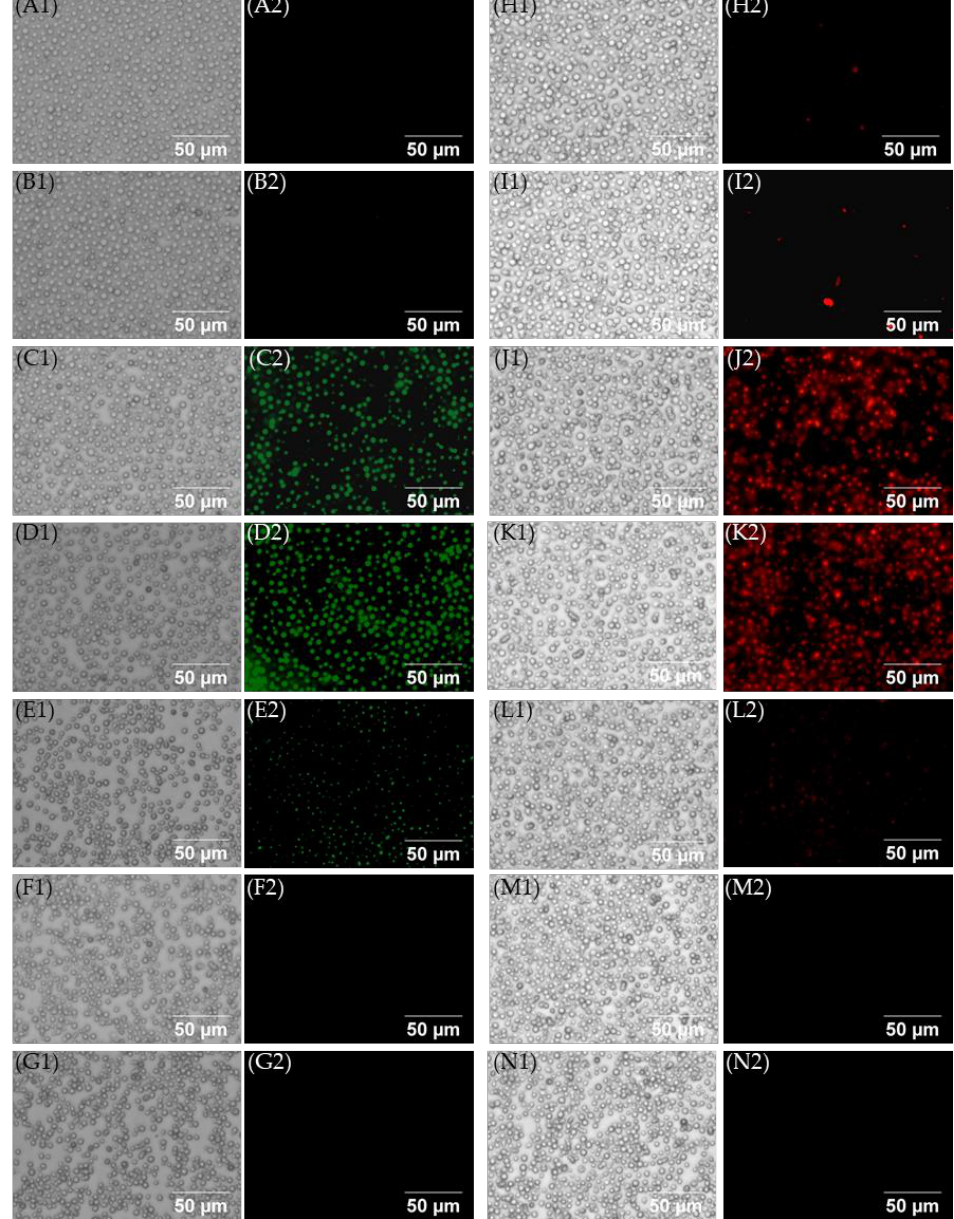
Figure 8. Images of C. neoformans treated with varied concentrations of compound 11 . ( A1,A2 ) Cells treated with only SYTOX TM green; ( B1,B2 ) cells treated with Triton X-100 and SYTOX TM green; ( C1,C2 ) cells treated with 0.5×MIC of 11 and SYTOX TM green; ( D1,D2 ) cells treated with 1×MIC of 11 and SYTOX TM green; ( E1,E2 ) cells treated with 2×MIC of 11 and SYTOX TM green; ( F1,F2 ) cells treated with 4×MIC of 11 and SYTOX TM green; ( G1,G2 ) cells treated with 8×MIC of 11 and SYTOX TM green; ( H1,H2 ) cells treated with only PI; ( I1,I2 ) cells treated with Triton X-100 and PI; ( J1,J2 ) cells treated with 0.5×MIC of 11 and PI; ( K1,K2 ) cells treated with 1×MIC of 11 and PI; ( L1,L2 ) cells treated with 2×MIC of 11 and PI; ( M1,M2 ) cells treated with 4×MIC of 11 and PI; ( N1,N2 ) cells treated with 8×MIC of 11 and PI.